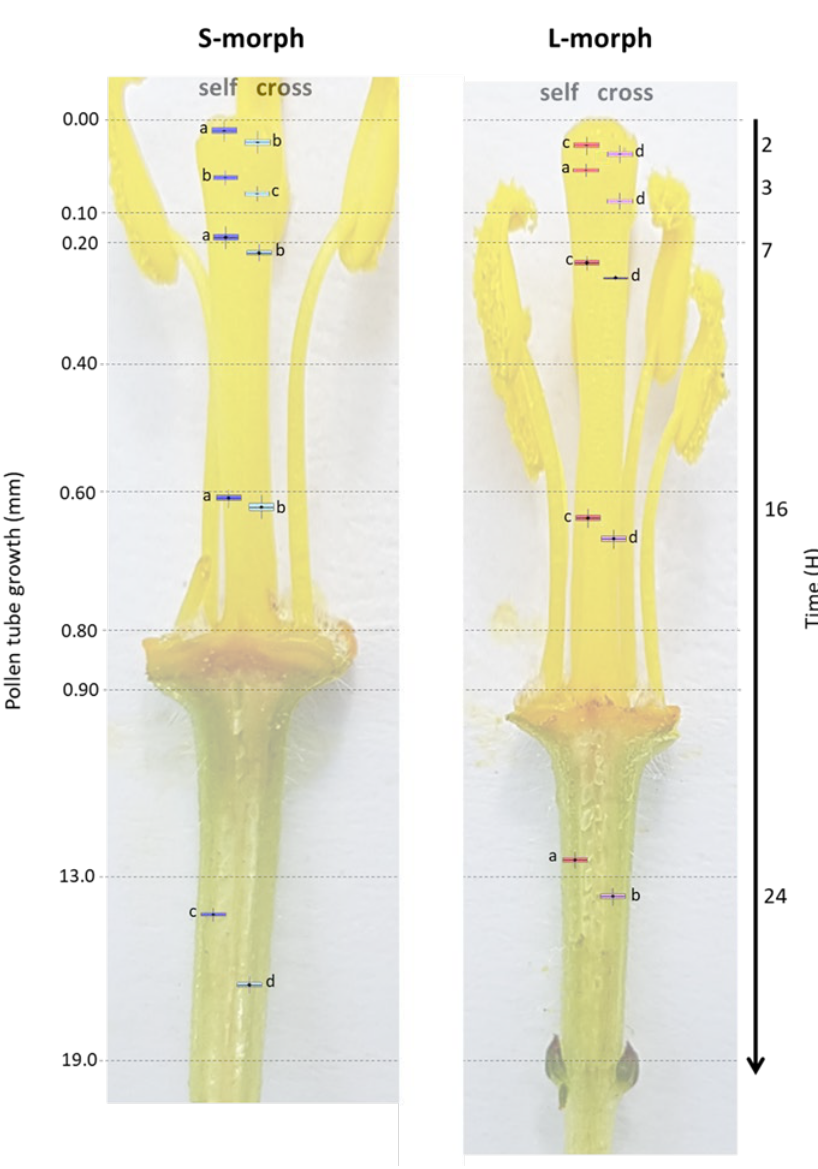
Figure 3: Kinetic of pollen tube elongations in both floral morphs in Ludwigia grandiflora subsp. hexapetala . a) Kinetic of pollen tube elongations in S-morph styles when self- and cross-pollinated (left, blue and sky-blue boxes respectively); b) Kinetic of pollen tube elongations in L-morph style when self- and cross-pollinated (right, red and pink boxes respectively). Significance letters were obtained using a Tukey’s honestly significant difference (HSD) post-hoc comparisons of the means. In both floral morphs, cross-pollen tubes elongated faster than